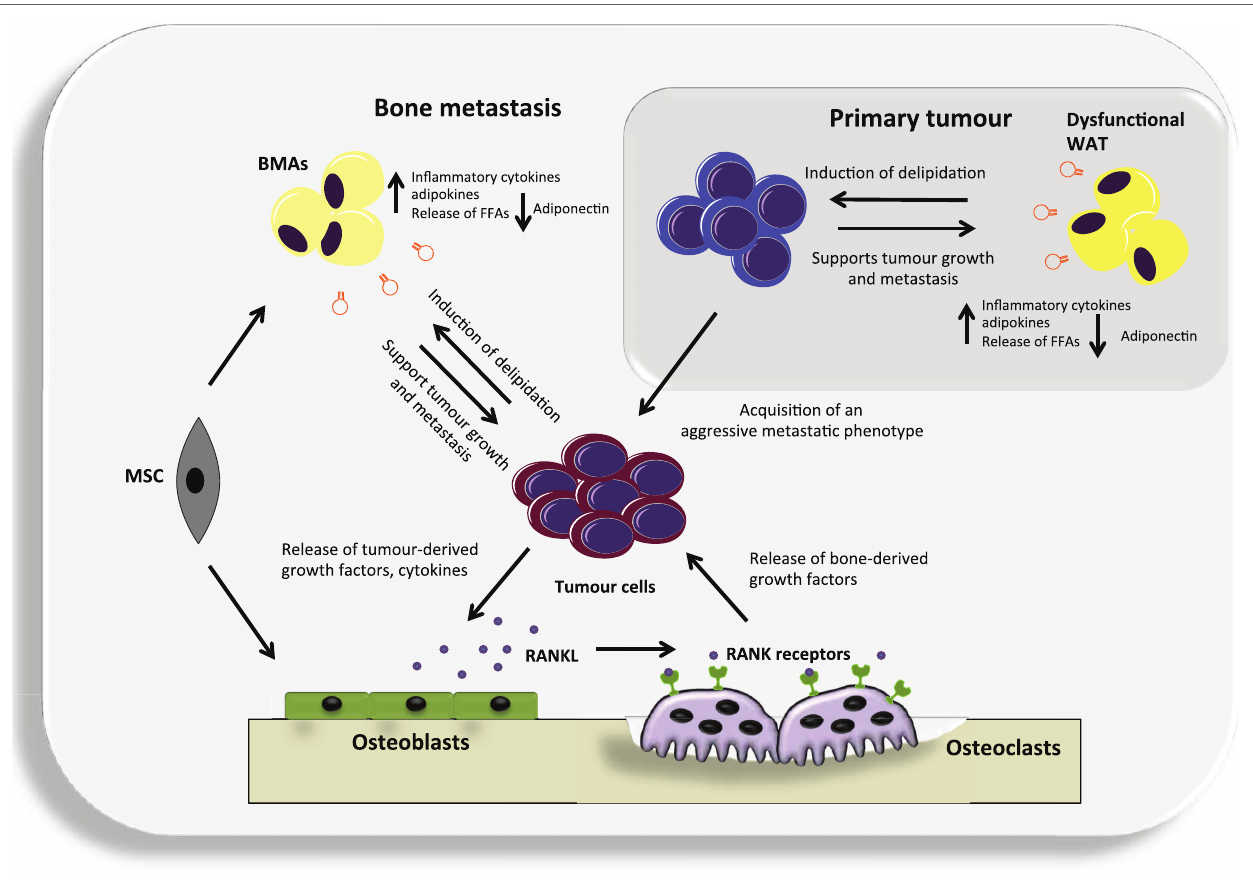
FiGURe 1 | An overview of the potential contribution of both white adipose tissue (wAT) and bone marrow adipocytes (BMAs) to the vicious cycle of bone metastases . Dysfunctional WAT releases an increased level of a number of adipokines and pro-inflammatory cytokines that can support tumor growth. In turn, cancer cells may cause delipidation of adipocytes to fuel their growth and the acquisition of an aggressive metastatic phenotype. They can then metastasize to the adipocyte-rich environment of the bone where they may continue to utilize BMAs generated from mesenchymal stem cells (MSC) that reside in the bone, as a source of fuel. Cancer cells residing in the bone produce various cytokines and growth factors that primarily target osteoblasts, causing them to increase their production of receptor activator of nuclear factor kappa-B ligand (RANKL). RANKL in turn targets the RANK receptor expressed by osteoclast precursors and leads to differentiated and activated osteoclasts. The osteoclasts degrade the bone releasing numerous factors. Many of these factors act positively upon the cancer cells resulting in a vicious